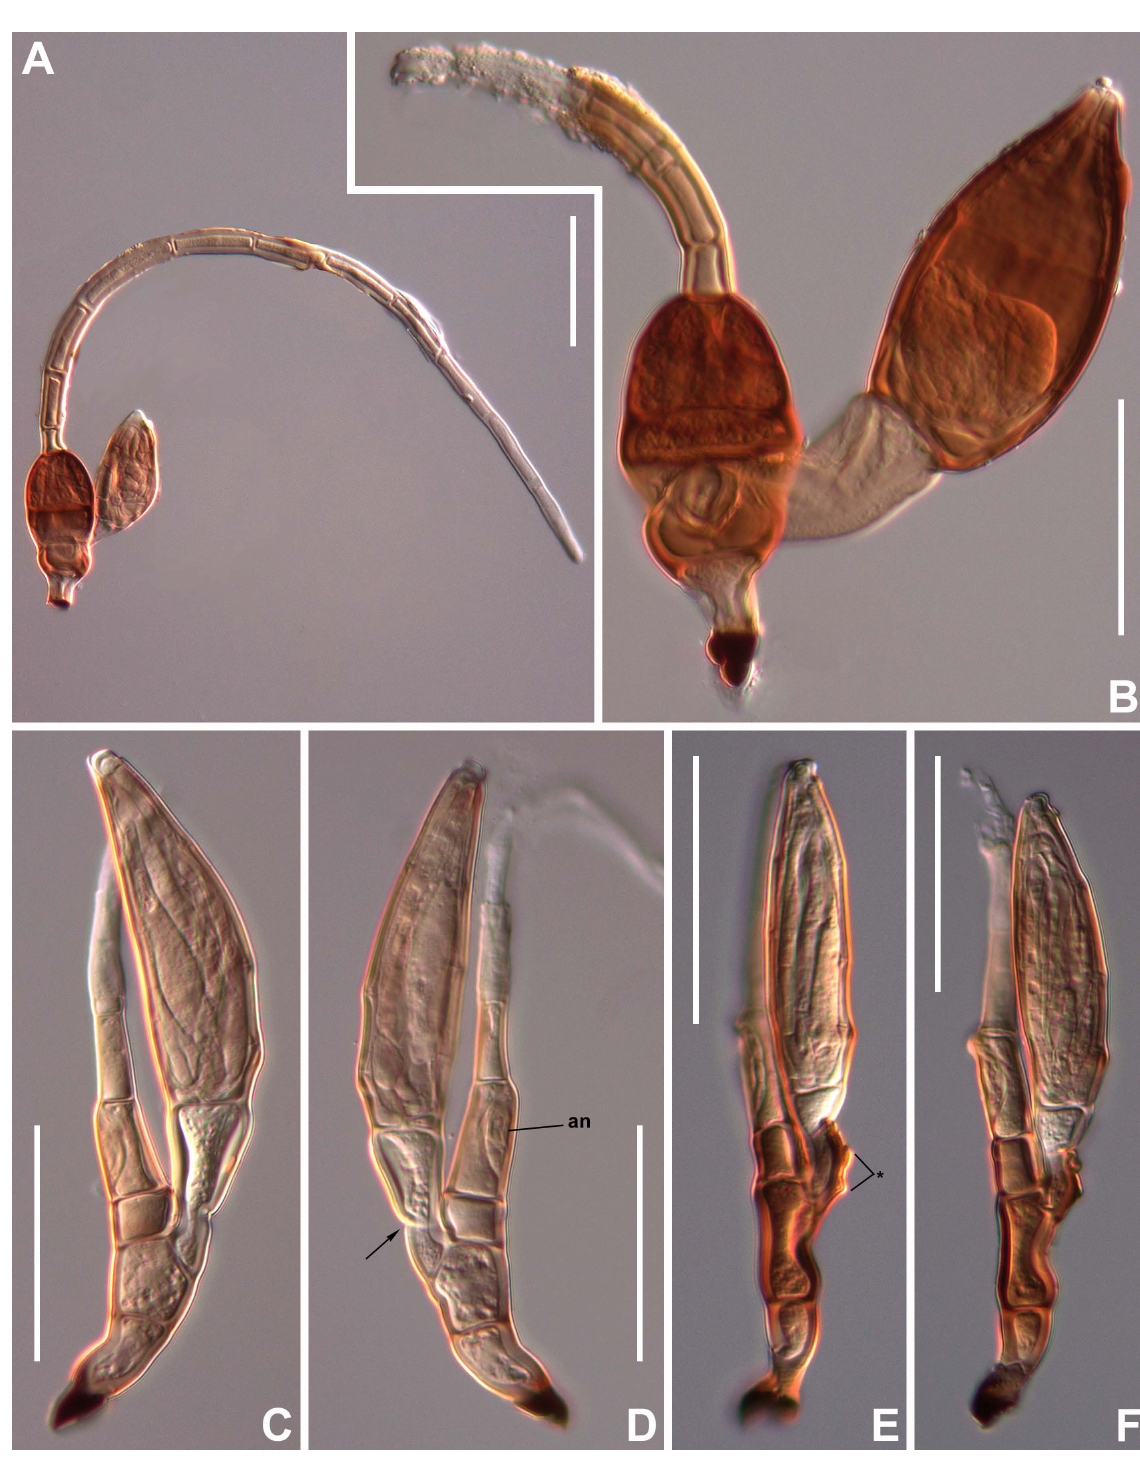
Fig. 76. Cantharomyces spp. A – B . C. elongatus Haelew. & De Kesel. A . Submature thallus with an undamaged appendage. B . Mature thallus. – C – F . C. italicus Speg. C – D . Typical thalli from the abdomen of the host, showing antheridium (an) and constriction of cell VI (arrow). E – F . Mature thalli from the pronotum of the host. In E, “*” points to cell VI corrugation. Scale bars: 50 µm. Photographs from slides ZMUC C-F-124174 (A), ZMUC C-F-124172 (B), ZMUC C-F-123549 (C–D), ZMUC C-F-124264